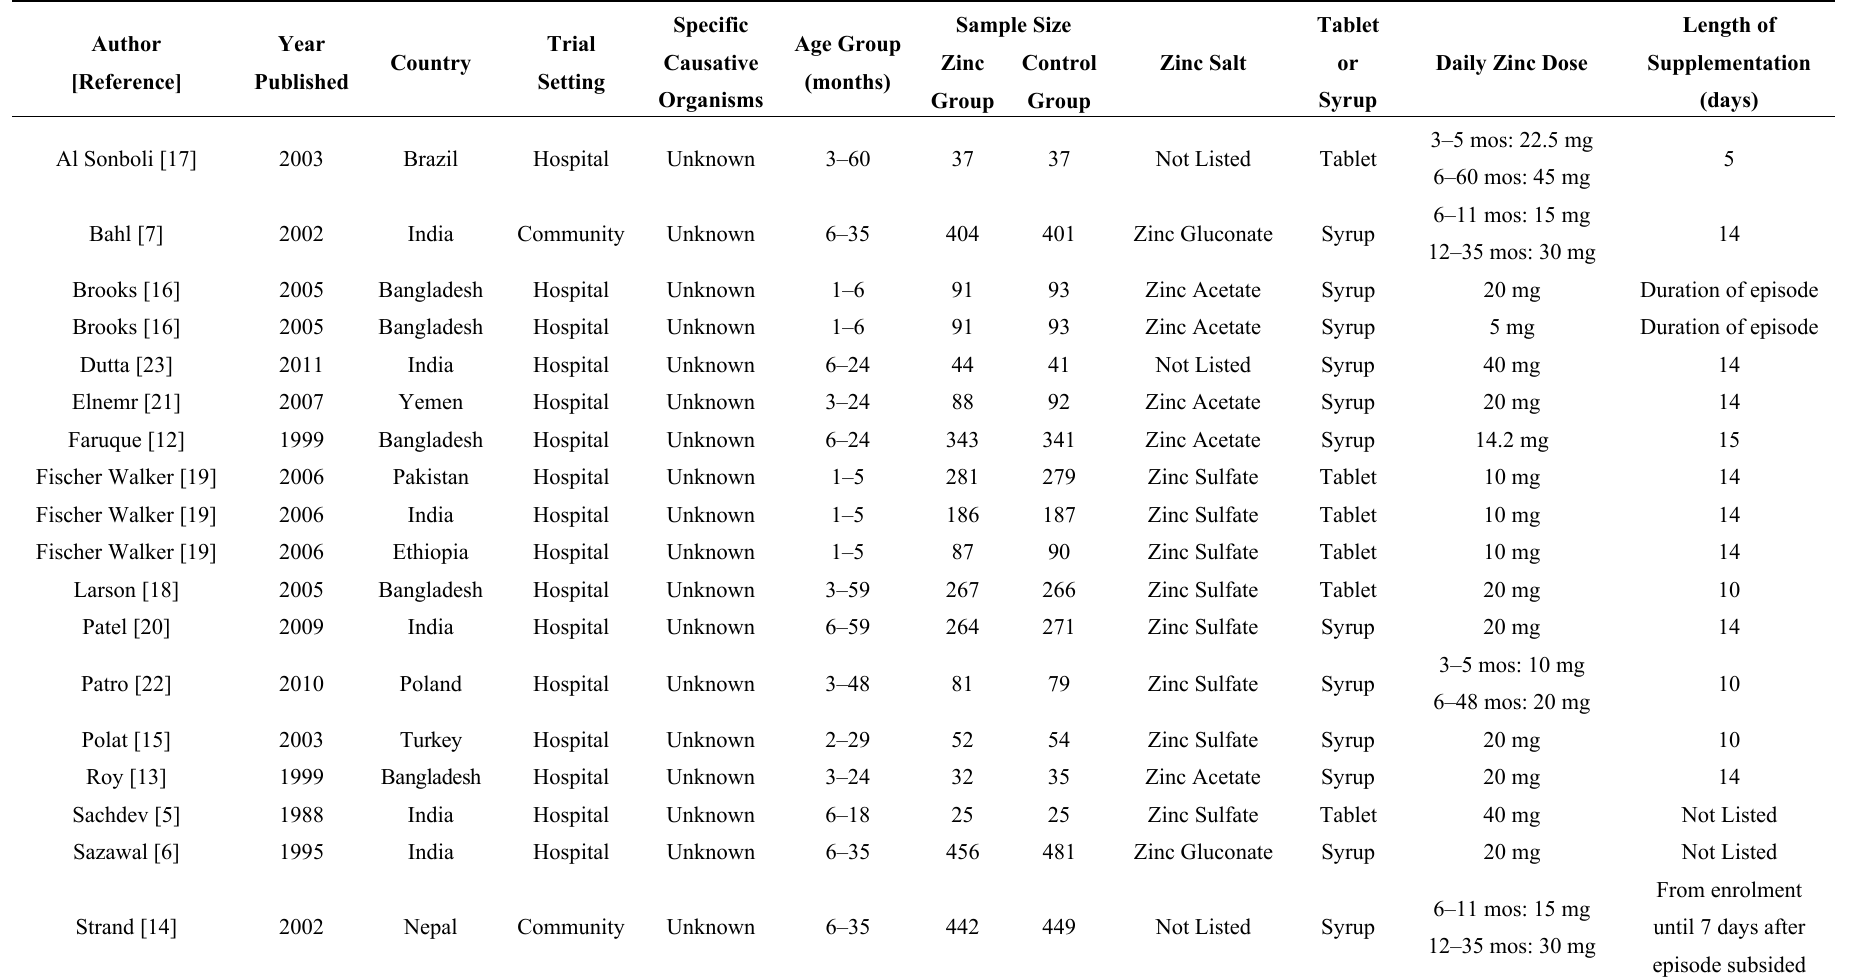
Table 1. Characteristics of included